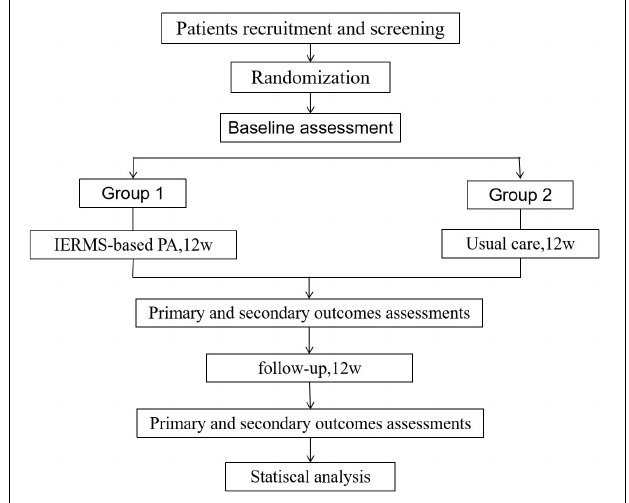
FIGURE 1 | Flow chart of the experimental